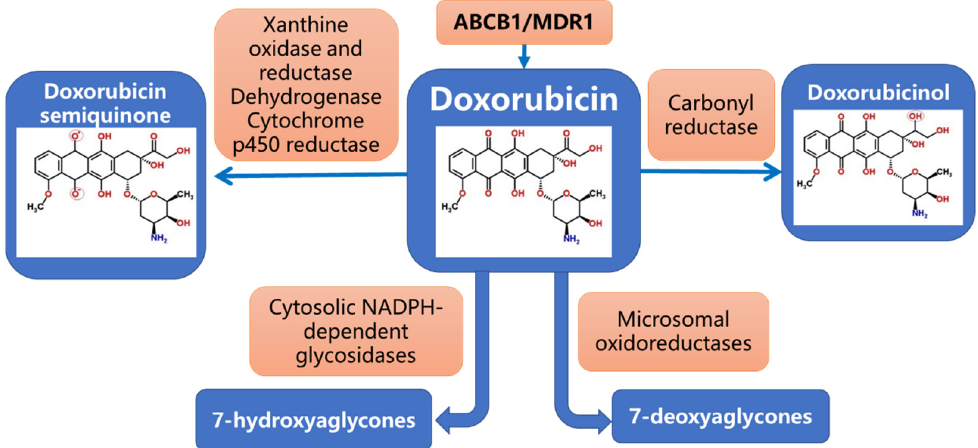
Figure 1. Major enzymes and products of doxorubicin metabolism pathway.